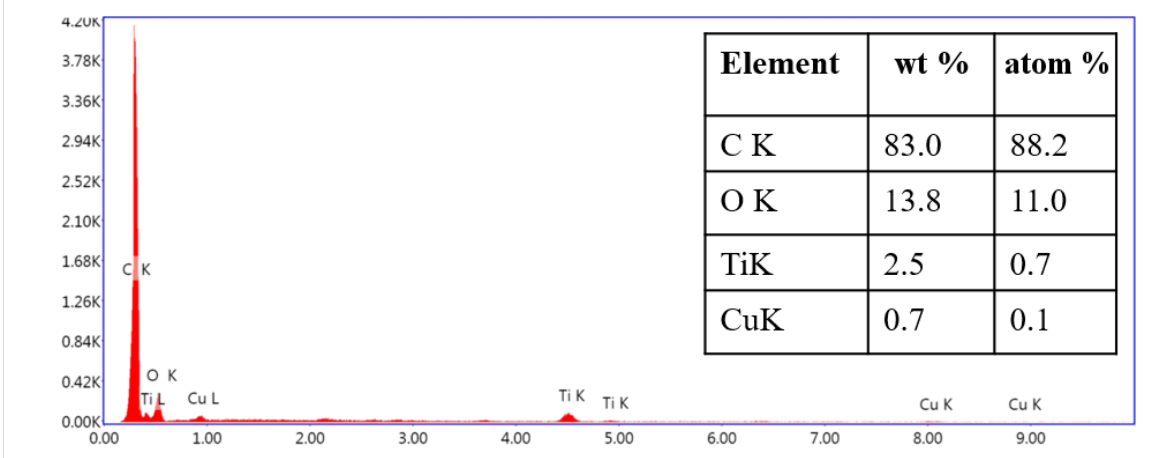
Figure 8: Energy dispersive X-ray spectrum of Cu/CuO/PCNF/TiO 2 .